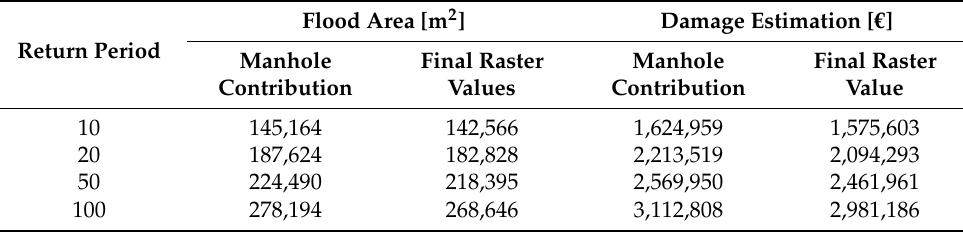
Table 6. Differences in results for manhole contribution and final raster values.